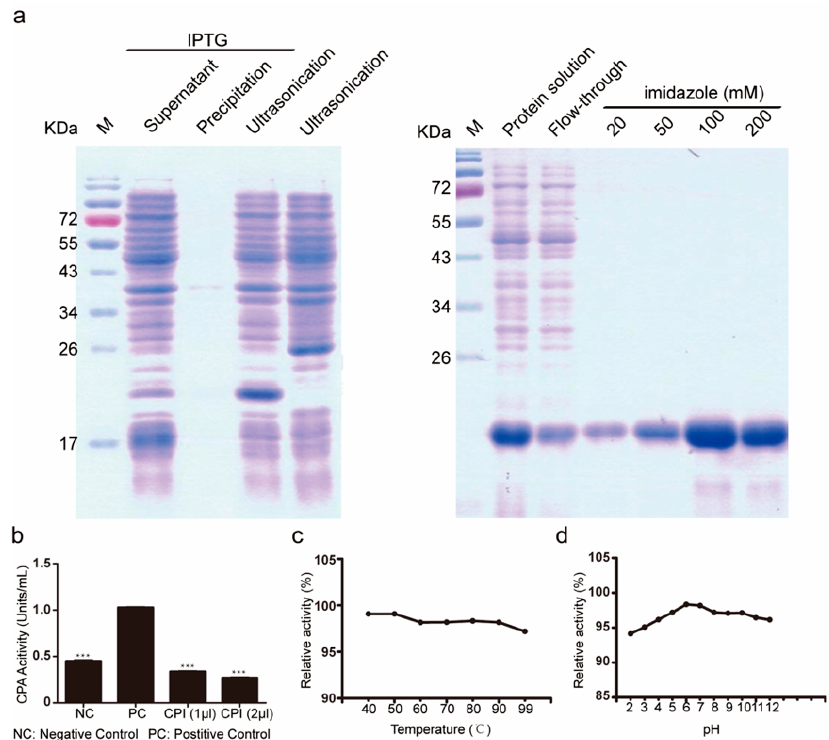
Figure 1. The expression and activity evaluation of recombinant silkworm carboxypeptidase inhib- itor. ( a ) Prokaryotic expression, isolation, and purification of silkworm carboxypeptidase inhibitor protein. ( b ) Determination of the inhibitory activity of recombinant silkworm carboxypeptidase in-